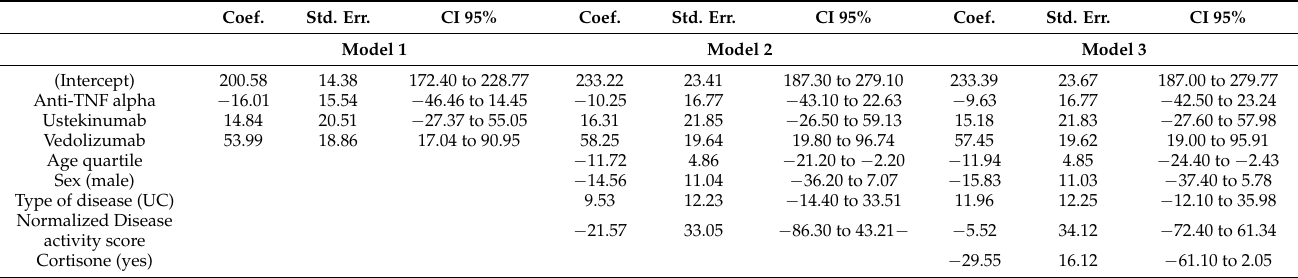
Table 6. Rank-based estimation regression on T2 S1/S2 IgG SARS-CoV-2.